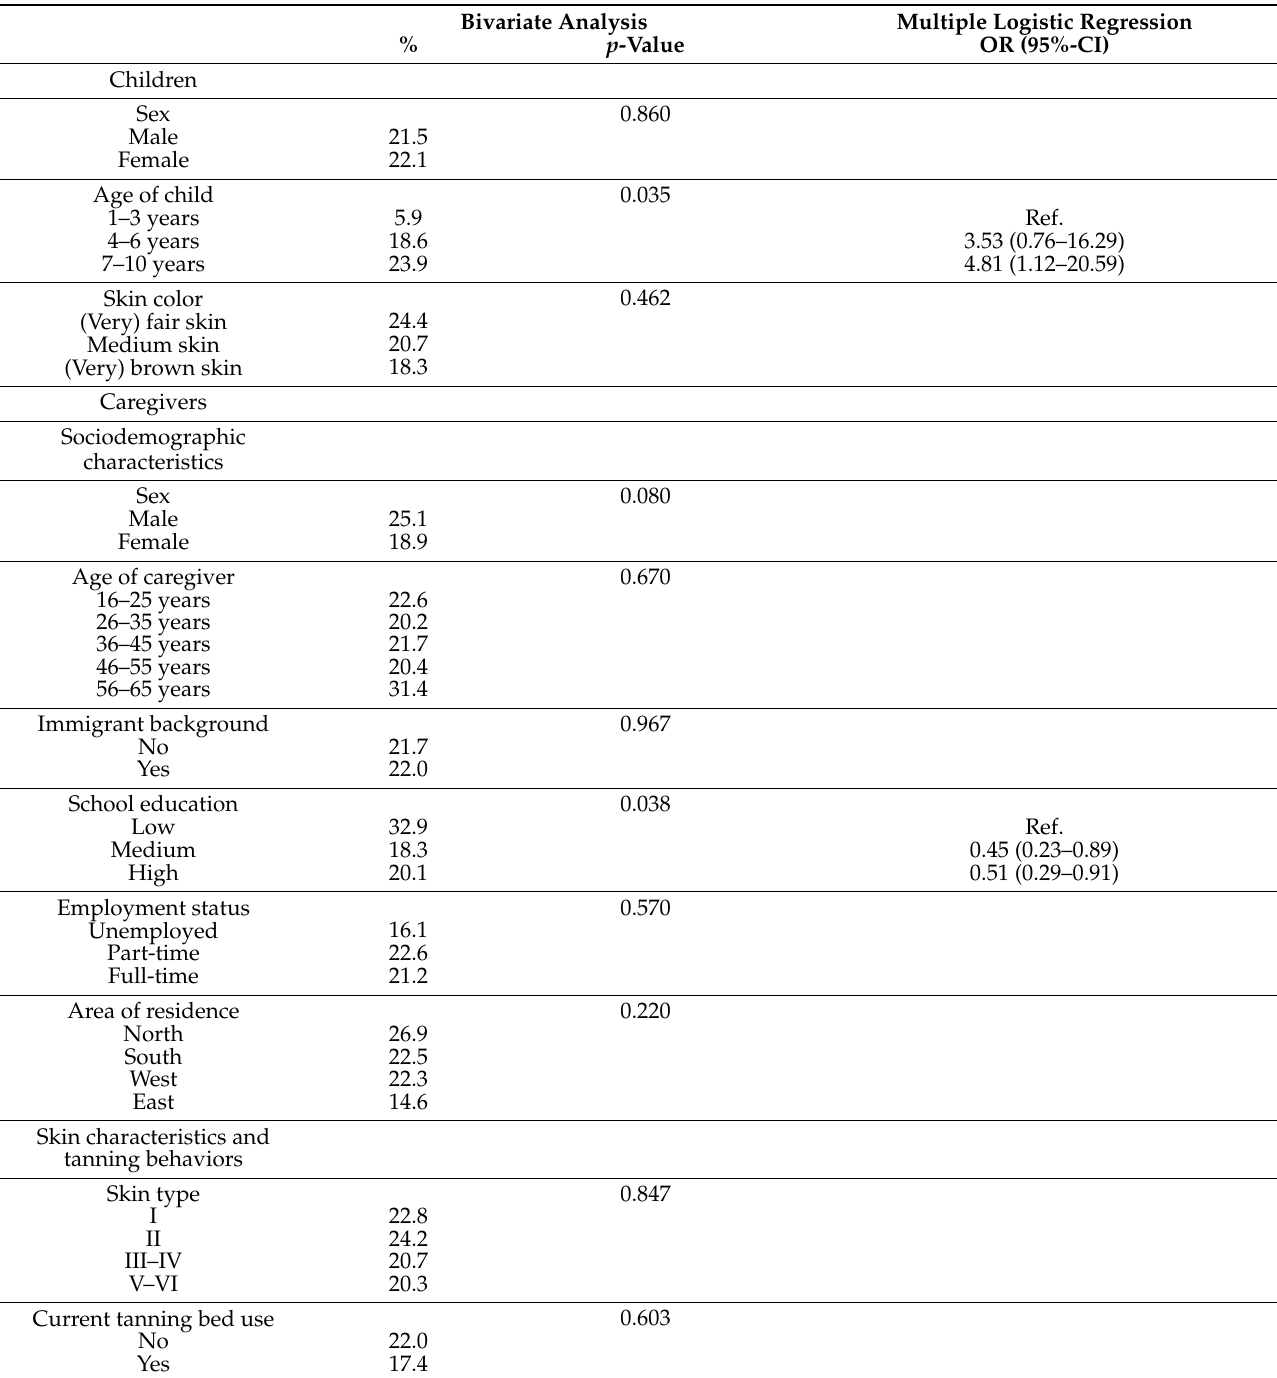
Table 5. Bivariate analyses and multiple logistic regression addressing children’s sunburn (at least one sunburn in the